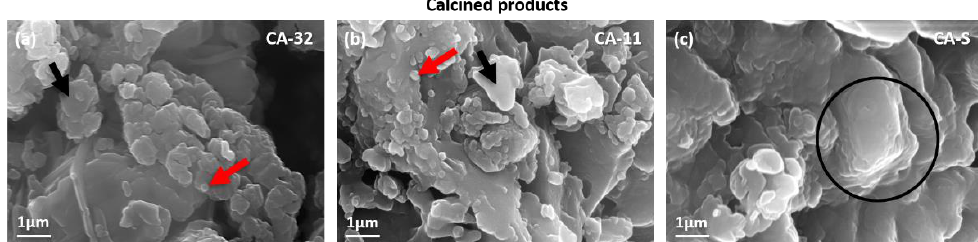
Figure 5. Scanning electron microscopy (SEM) images at magnification = 100 k of calcined products CA-32 ( a ), CA-11 ( b ) and CA-S ( c ).